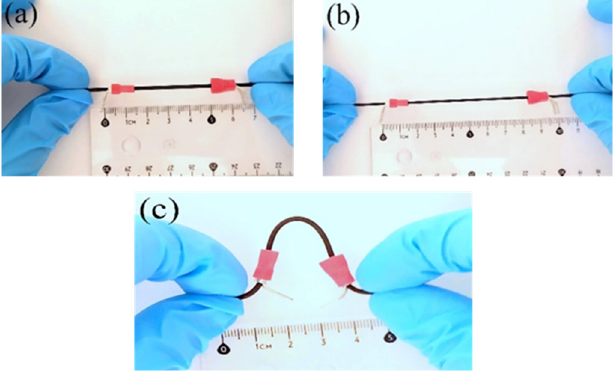
Figure 6. Pictorial representation of the SEBS/CB 15% sample in ( a ) unstretched, ( b ) stretched, and ( c ) bent form.